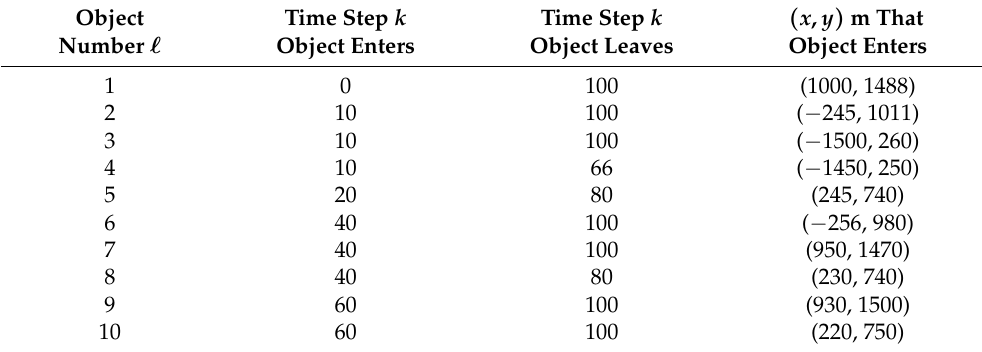
Figure 2. True ( x , y ) -coordinates for the moving 10 objects in Example 1; the object number and the coordinate at which the object enters the scene (marked by (cid:63) ) are listed in Table 1. Table 1. Enumerated objects in Experiment 1 with time steps at which (cid:96) th object enters and leaves the scene and ( x , y ) -coordinate at which object enter the